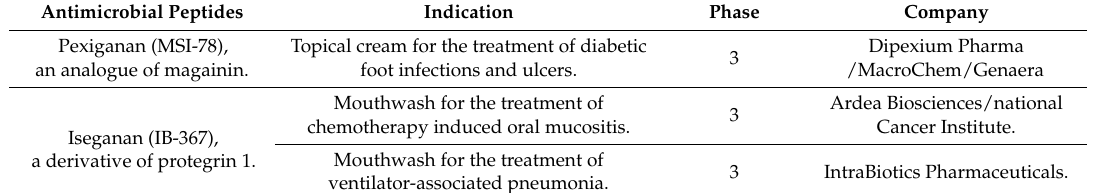
Table 2. Major examples of antimicrobial peptides (AMPs) in clinical trials or in development [12–15]. Antimicrobial